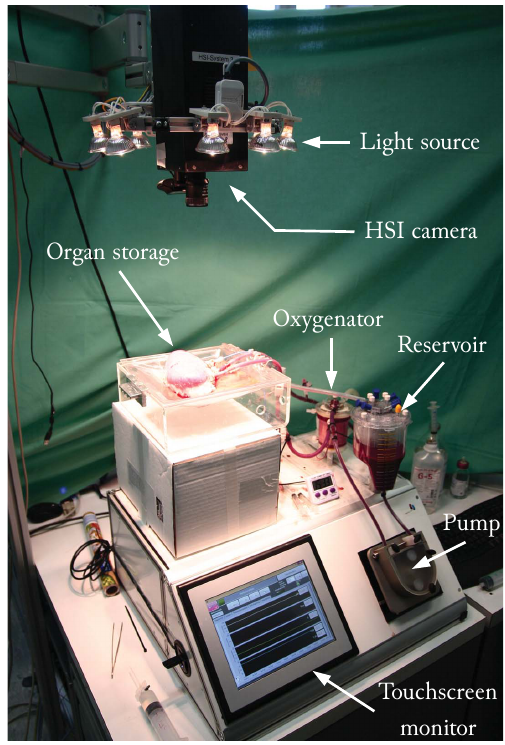
Figure 1. Measurement setup for hyperspectral imaging during nor- mothermic kidney perfusion with the perfusion system developed at the Institute of biomedical engineering, Technical University Dres-